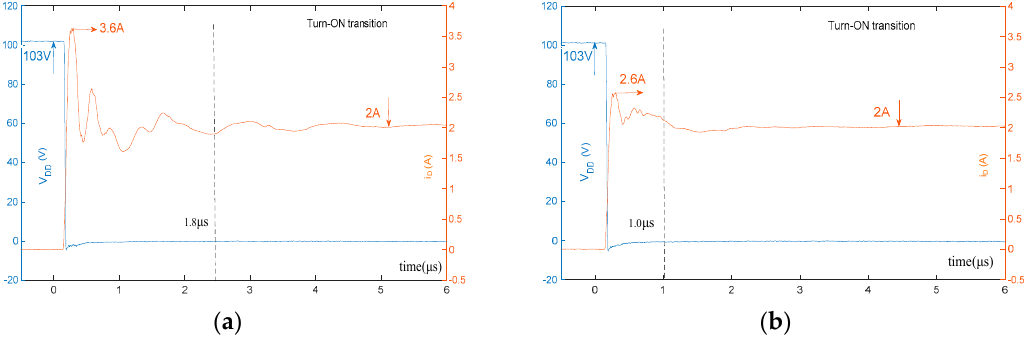
Figure 17. Turn-on transient under the condition of V in = 103 V, I L = 2.0 A, C X = 0.68 nF. ( a ) Turn-on transient without a ferrite ring; ( b ) Turn-on transient with a ferrite ring.